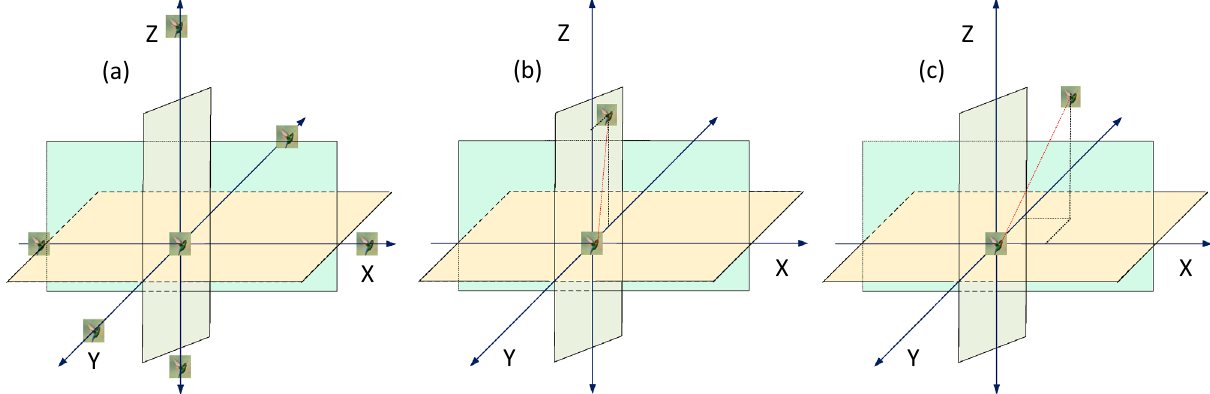
Figure 3. Hummingbirds flying behavior: ( a ) axial fight, ( b ) diagonal flight, and ( c ) omnidirectional